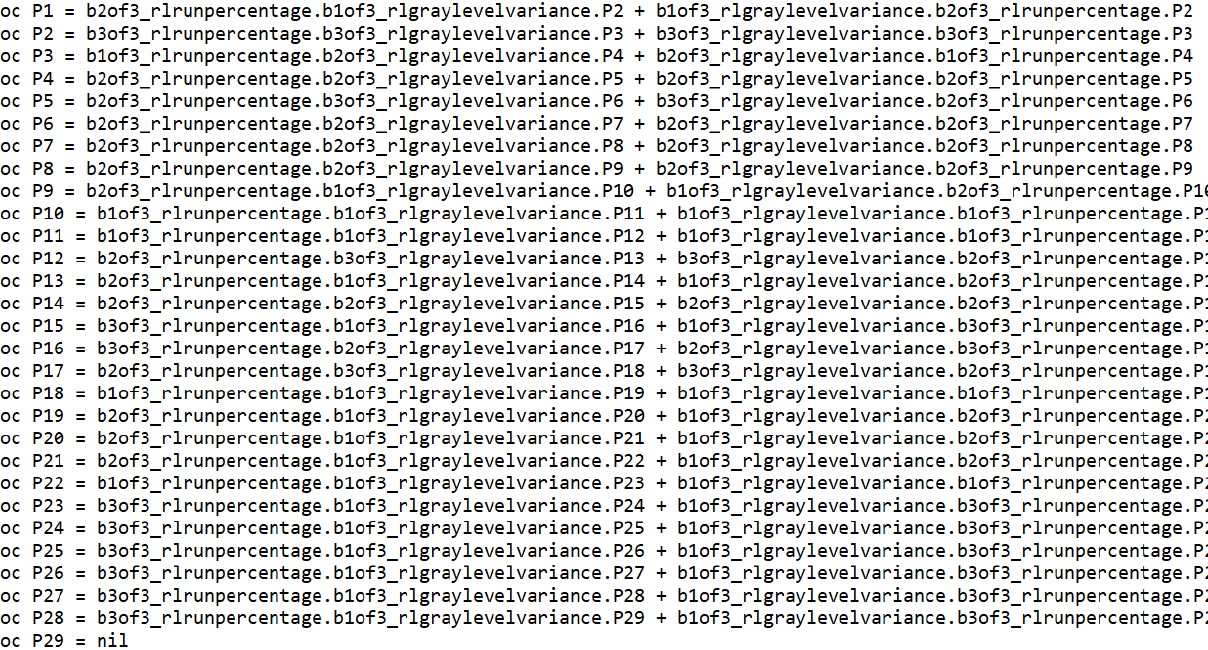
Figure A1. For reasons of coherence and clarity, the Figure above shows the LTS in the form of CCS processes for GLRLM Feature class. For further information, please refer to Milner’s book